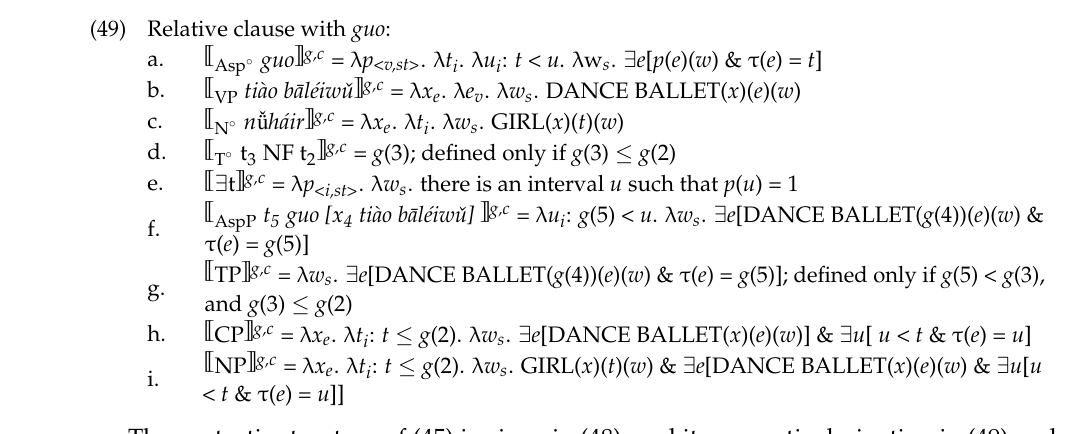
3.1. Relative Clauses with Bare